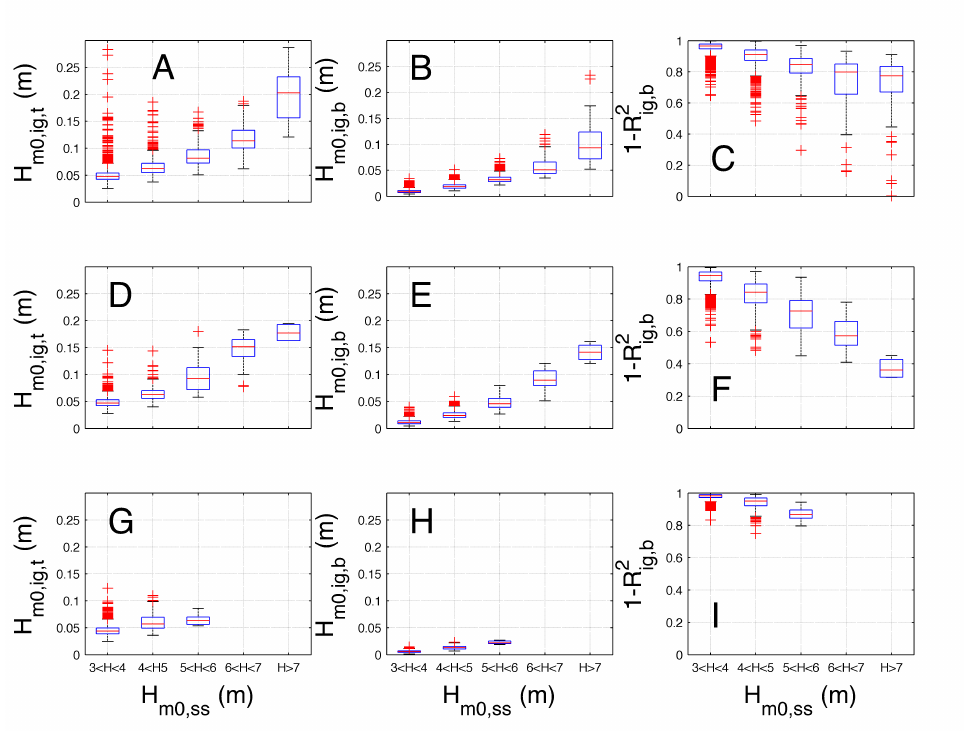
Figure 8. ( A , D , G ) Box-whisker plots of the total IG wave height as a function of the binned sea-swell wave height at A12, Q1 and EUR, respectively. ( B , E , H ) Box-whisker plots of the bound IG wave height as a function of the binned sea-swell wave height at A12, Q1 and EUR, respectively. ( C , F , I ) Box-whisker plots of the contribution of the free IG waves to the total IG variance at A12, Q1 and EUR, respectively. The box includes the 25 to 75 percentiles with the median in red. Outliers are given by the red plus